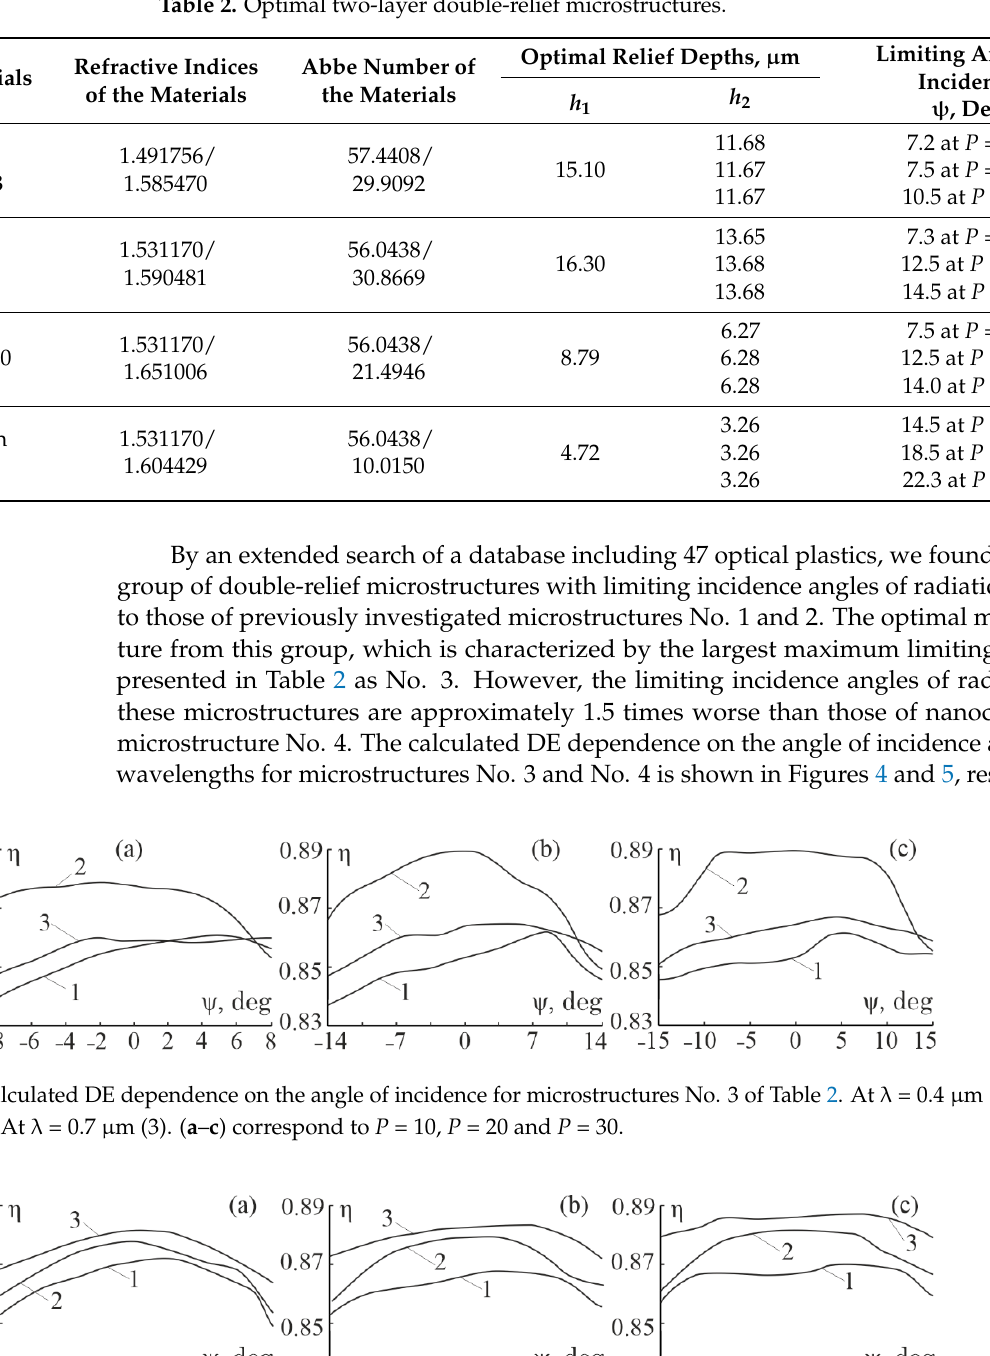
Table 2. Optimal two-layer double-relief microstructures.